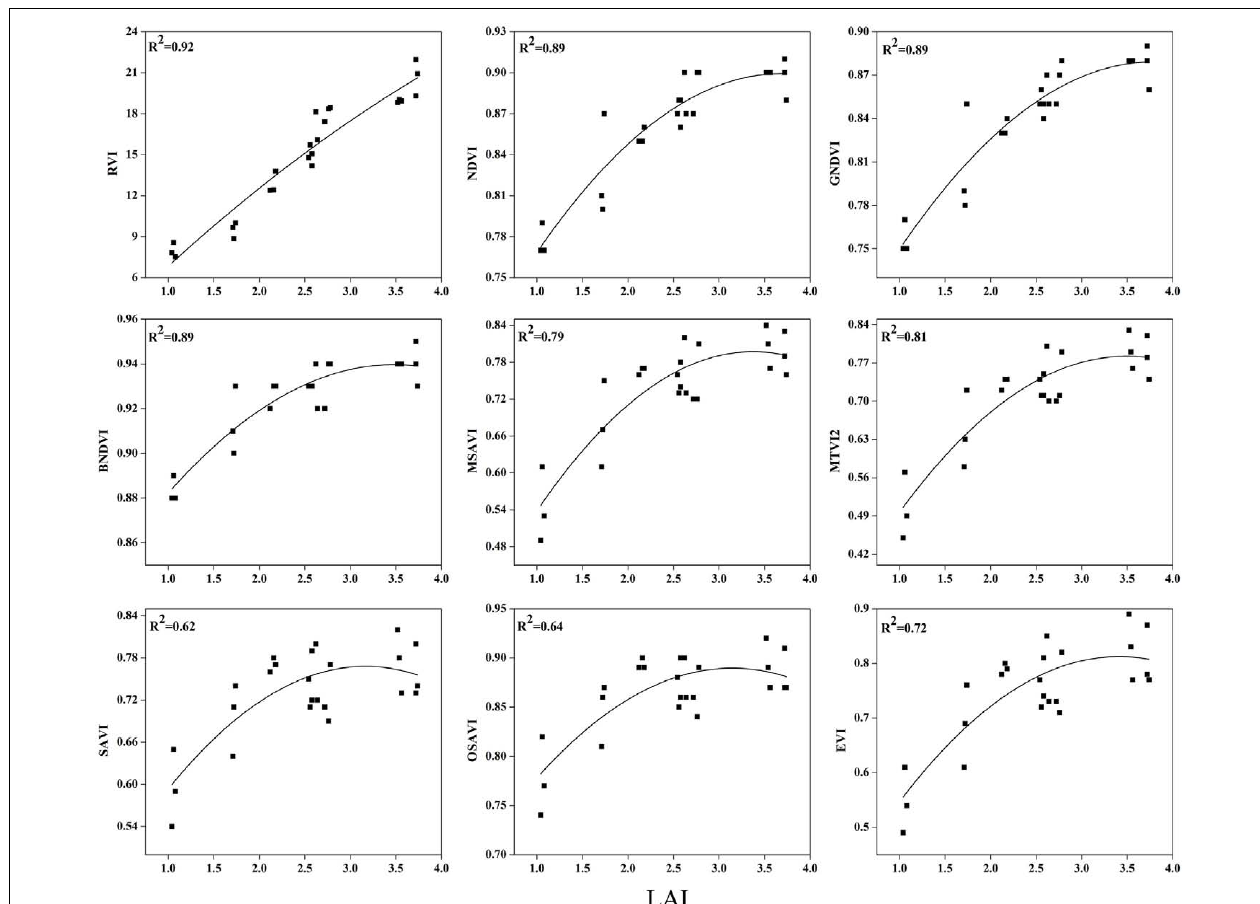
FIGURE 7 | Best-fit models between vegetation indices (VI) and LAI at elongation stage.